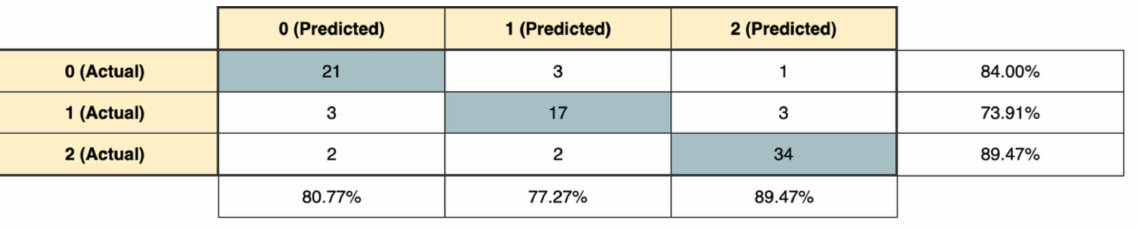
Figure 1. Receiver Operating Characteristic (ROC) curve of RF algorithm (blue line); ROC = 0.5, threshold for considering the model better than random guessing (black line).